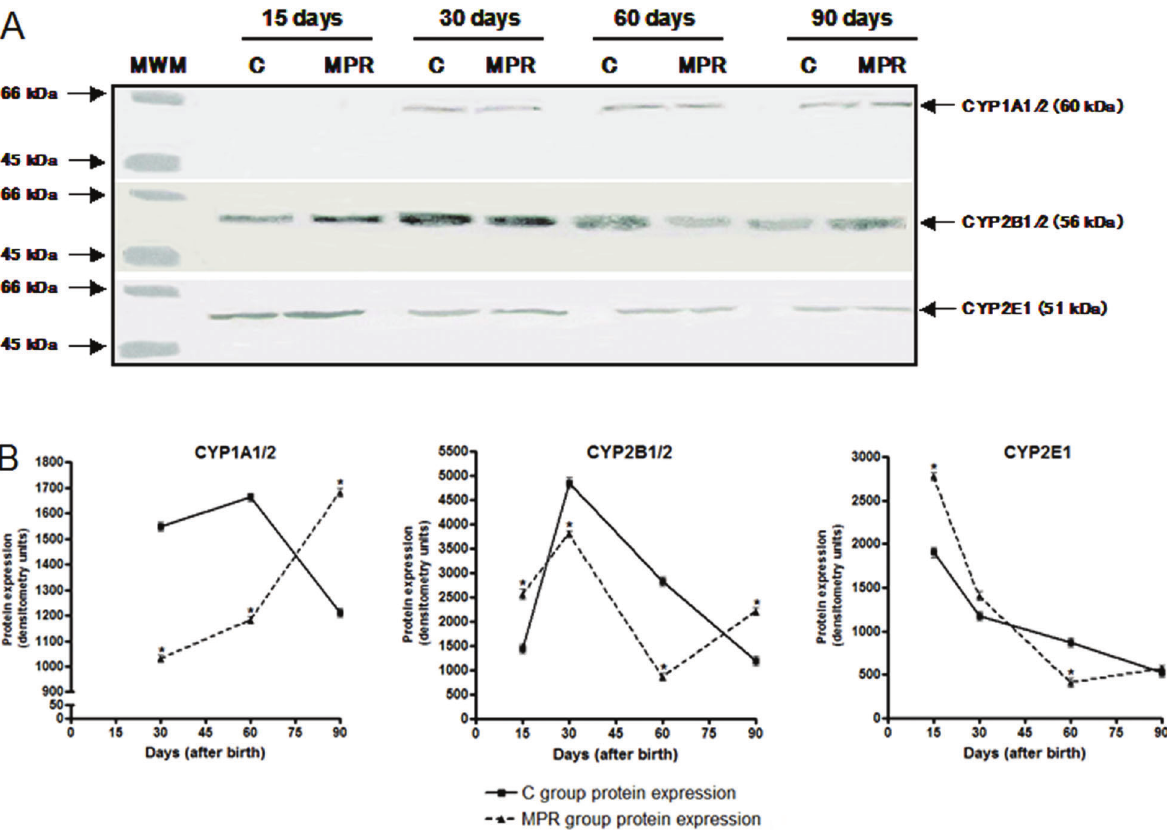
Figure 2. Maternal protein-free diet during lactation alters the offspring hepatic CYP2B1/2B2 protein expression levels at adulthood. A , representative images of hepatic CYP1A1, CYP1A2, CYP2B1, CYP2B2 and CYP2E1 protein expression in 15-, 30-, 60- and 90-day- old offspring from dams fed either a 0% protein (MPR groups) or a standard diet (C groups) during the fi rst 10 days of lactation, evaluated by western blotting. B , Densitometric analysis of CYP1A1/1A2, CYP2B1/2B2 and CYP2E1 protein expression. Data are reported as median and standard deviation of three biological replicates (protein expression data derived from three independent pools of 6 male rats from each group, i.e., N=3). MWM: molecular weight marker (containing serum bovine albumin and ovalbumin). *P o 0.05 for MPR samples compared to their C counterpart samples (Student ’ s t